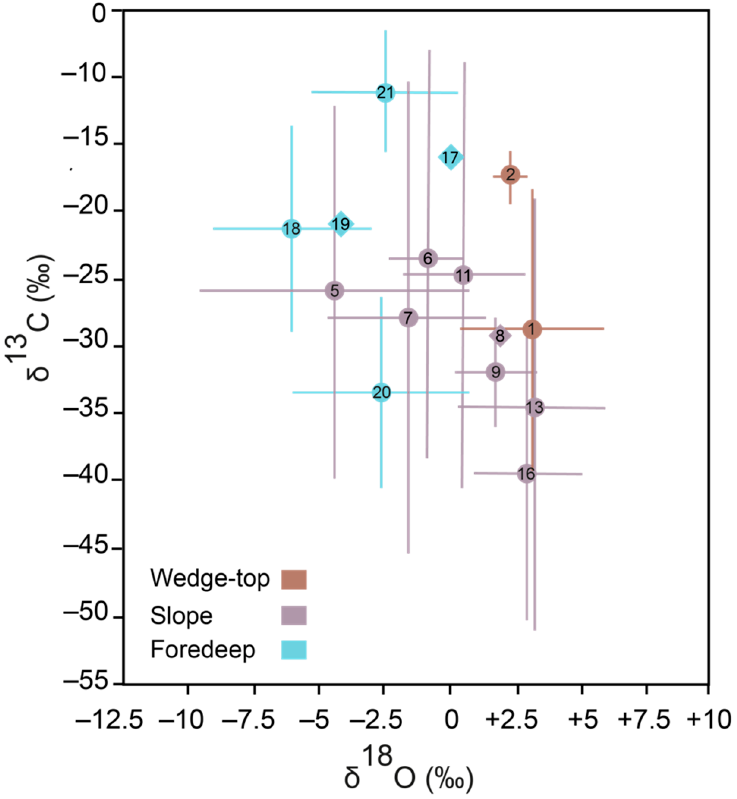
Figure 6. Carbon and oxygen isotopic values measured in seep-carbonates from the examined outcrops. The bar length represents the range of variability of the isotopic values; circles indicate the average of the endmember values and numbers specify the outcrop as listed in the caption of Figure 1. Rhombic features represent single measurement values.